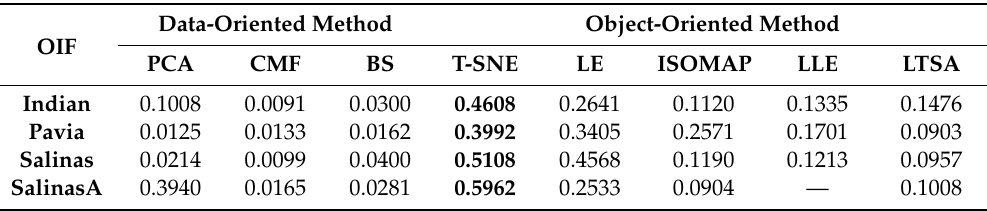
Table 1. Optimum Index Factor (OIF).